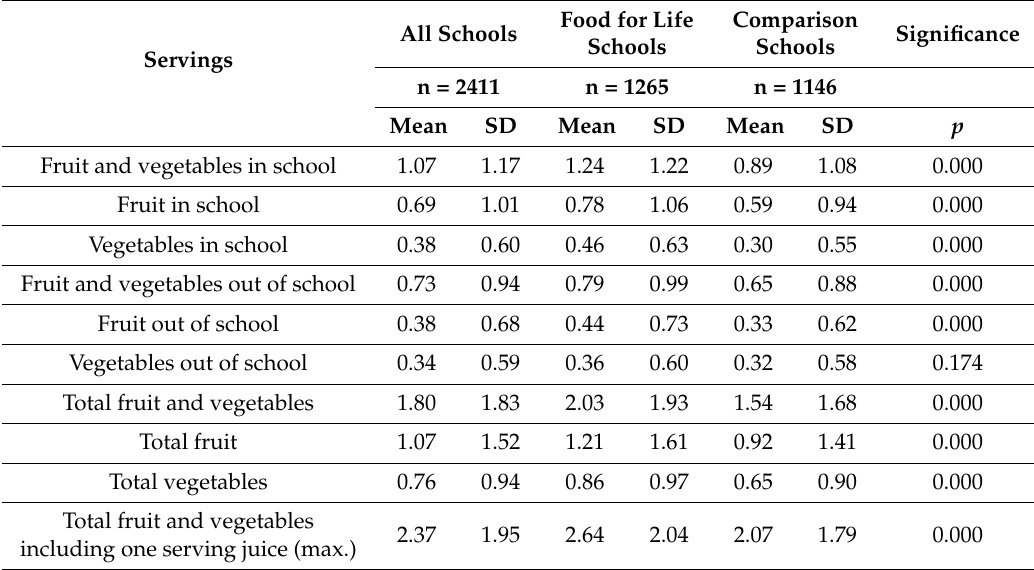
Table 4. Mean number of servings of fruit and/or vegetables consumed by pupils in Food for Life schools and Comparison schools.